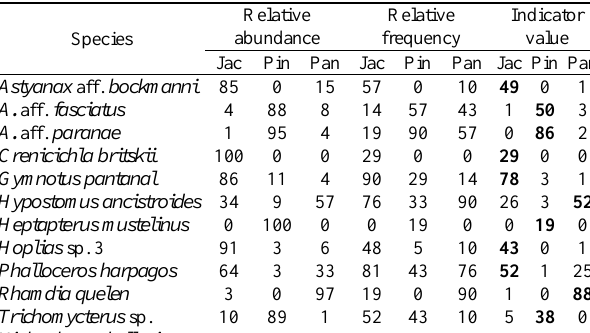
Table 3. Summary of the indicator species analysis: relative abundance, relative frequency, and indicator value for each stream (Jac, Jacutinga; Pin, Pinheirinho; Pan, Panambi) studied in the city of Toledo, State of Paraná, southern Brazil. Only species with significant values are shown. Values in boldface indicate significant indicator values (p < 0.05, Monte Carlo